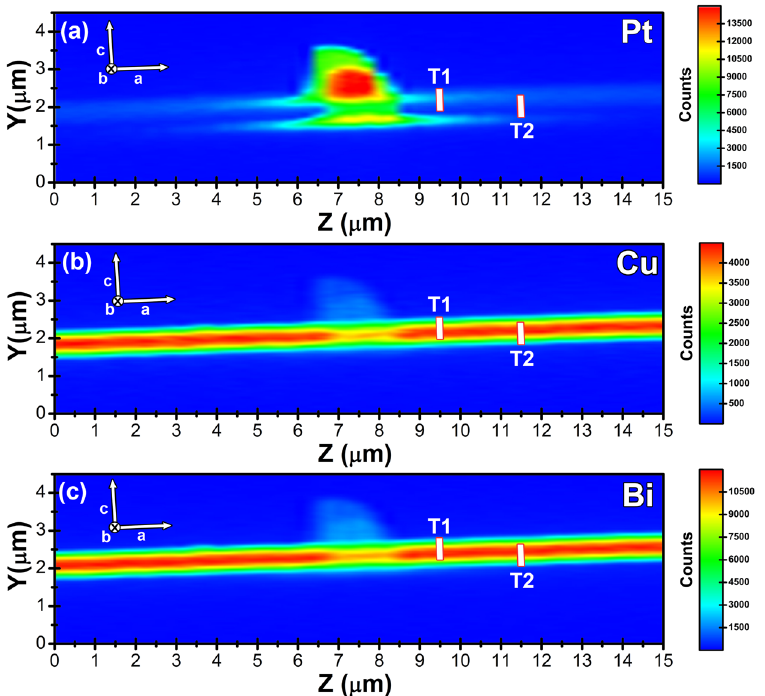
Figure 2. Spatial maps of the integrated XRF counts for Pt L α ( a ), Cu K α ( b ), and Bi L β ( c ) emission lines. The white rectangles highlight the regions which have been irradiated to realize the first (T1) and second (T2) trenches. The beam is parallel to the [0 1 0] crystallographic